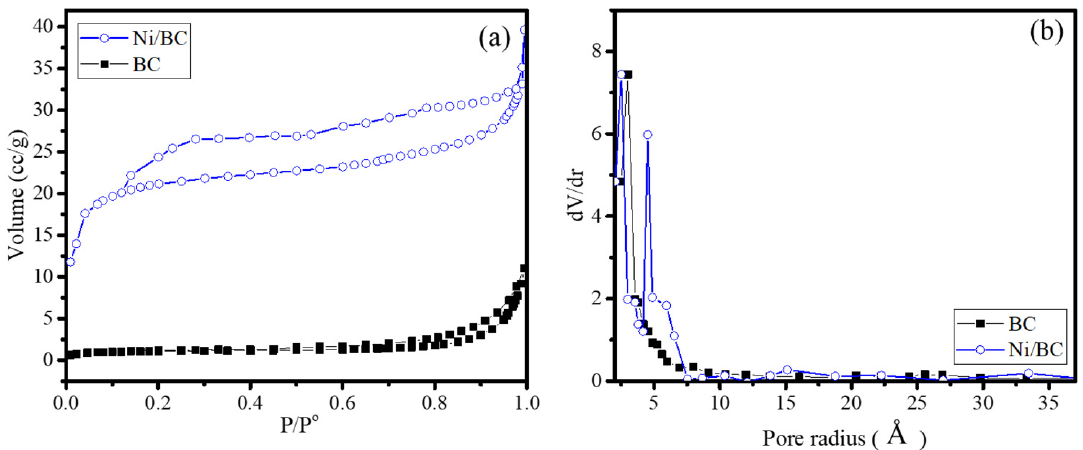
Figure 4. ( a ) Adsorption-desorption isotherm; ( b ) Pore size distribution of BC and Ni/BC. Table 2. BET specific surface area, pore volume and pore radius of BC and Ni/BC. Parameter BC Ni/BC Specific surface area (m 2 /g) 3.92 74.12 Pore volume